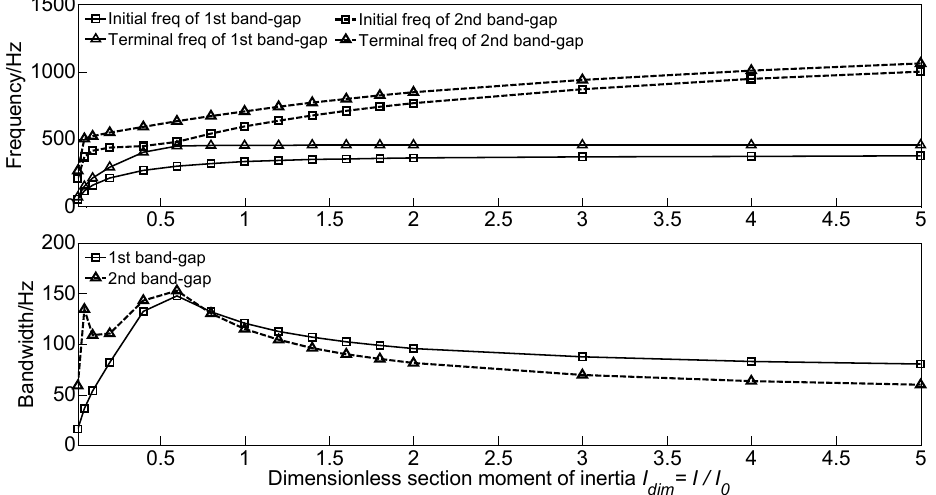
Figure 11. Band gaps maps as functions of dimensionless section moment of inertia I dim.